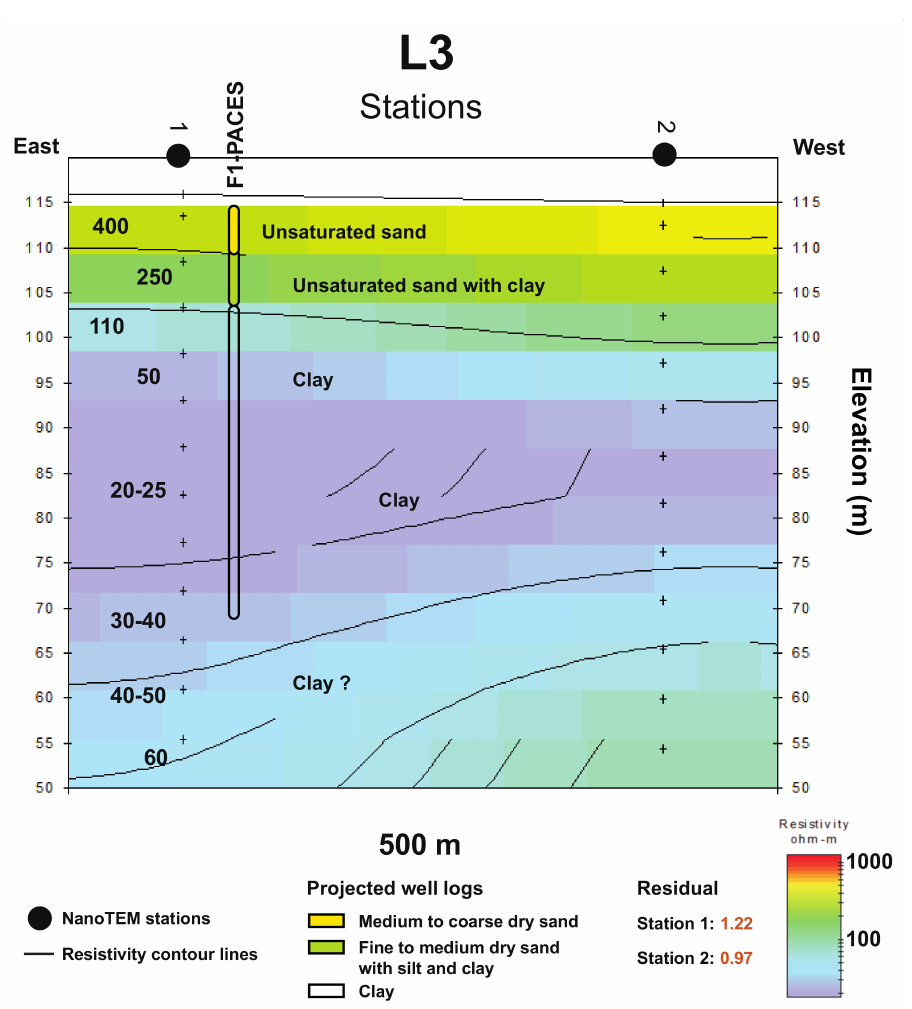
Figure 6. Interpreted 2D Section L3 and borehole F1-PACES collected near Saint-Maurice, Quebec. The surface deposit elevation is obtained from lidar data. At the site, no groundwater was observed, and the basement was completely dry and mainly composed of